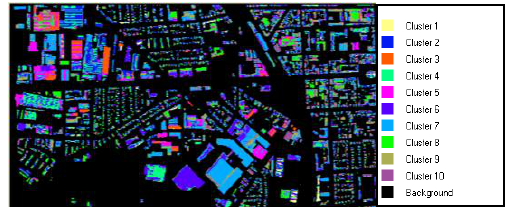
Figure 1: Output map of unsupervised classification